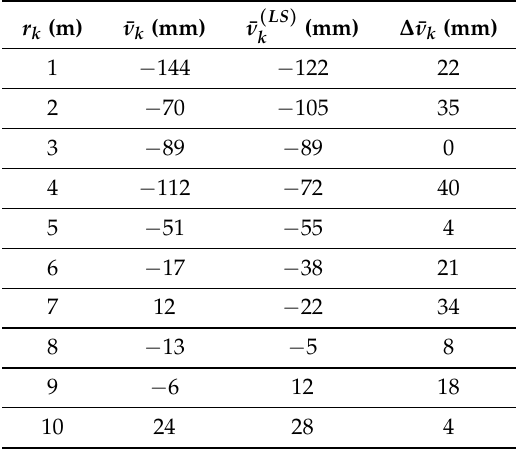
Table 1. This table shows the values of ¯ ν k (second column), their linear approximation ¯ ν column), and the absolute value ∆ ¯ ν k of their difference (fourth column), as a function of the true distances r k